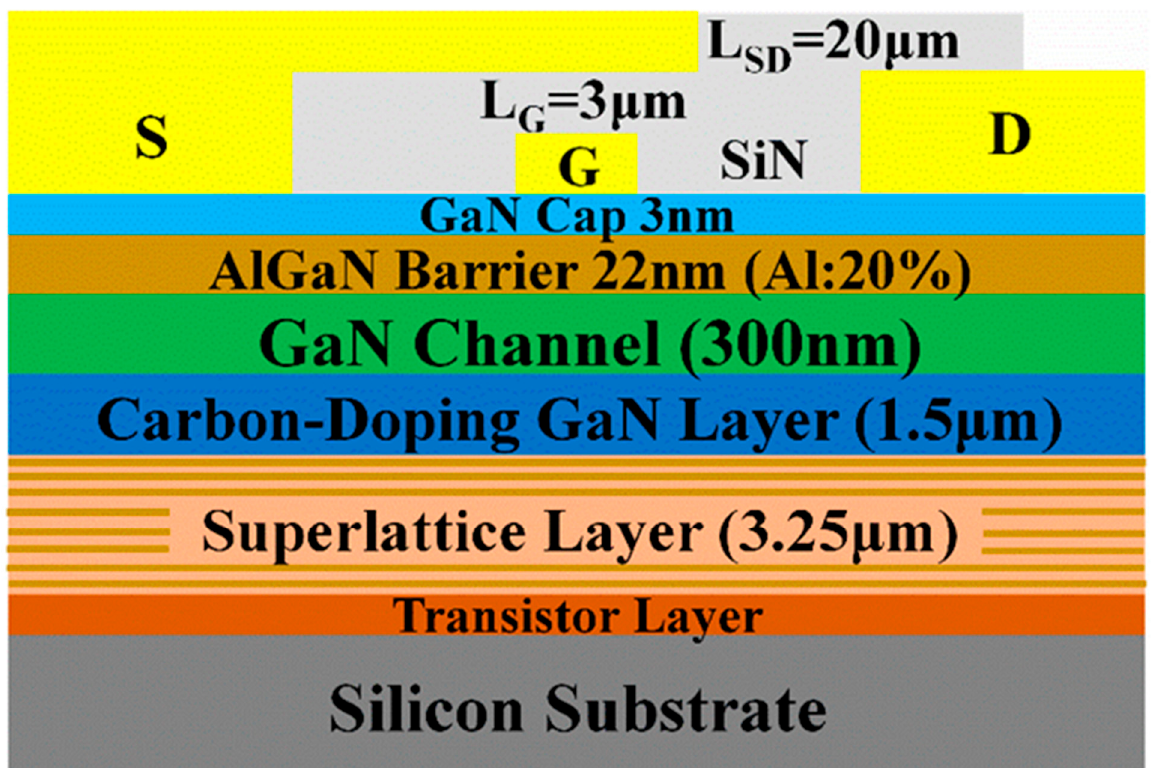
Figure 1. Schematic cross section of the GaN-on-Si device with superlattice buffer.